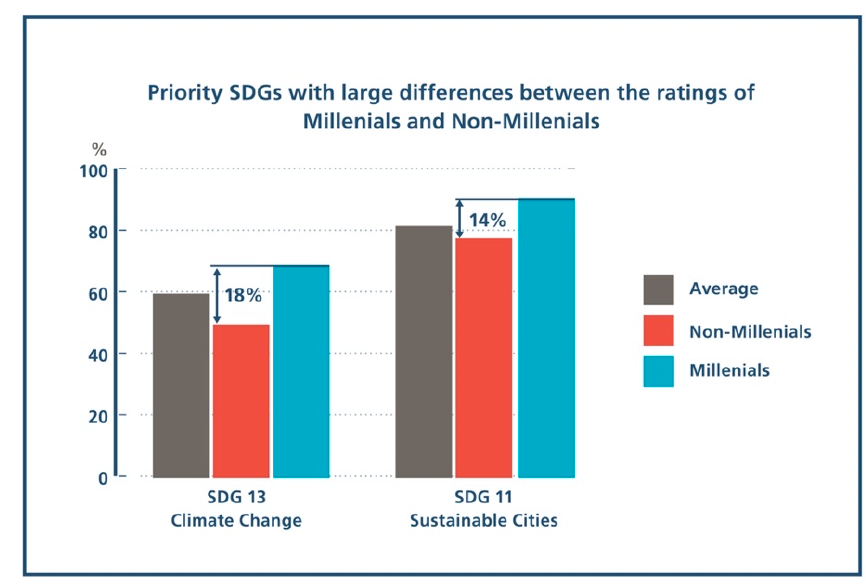
Figure 8. Responses of participants to their five top SDGs that engineering projects should measure impact against, showing the top seven list (with six and seven being significantly less popular).